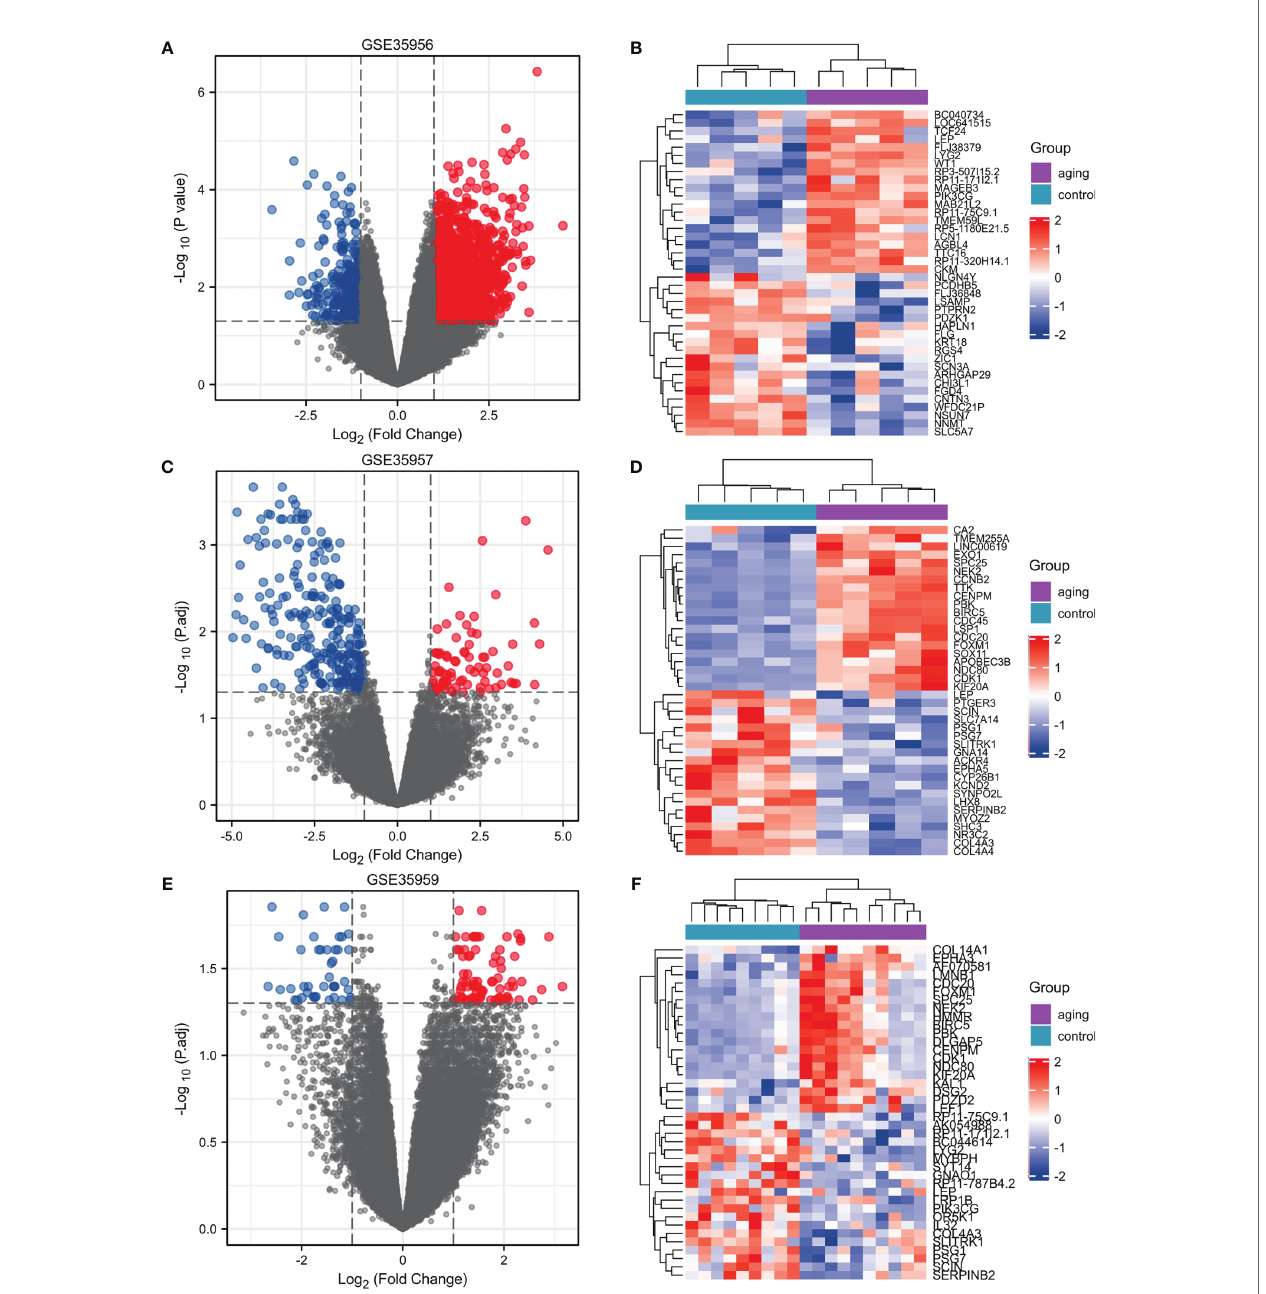
FIGURE 1 | Identi fi cation of DEGs in osteoporosis patients and non-osteoporotic donors. (A – F) Three volcano plots and Heat maps show all the expressed genes from GSE35956, GSE35957 and GSE35959. Blue and red in (A – F) respectively represent the down and up regulated genes. Each column represents a probe, and each row represents a gene. DEGs, differentially expressed